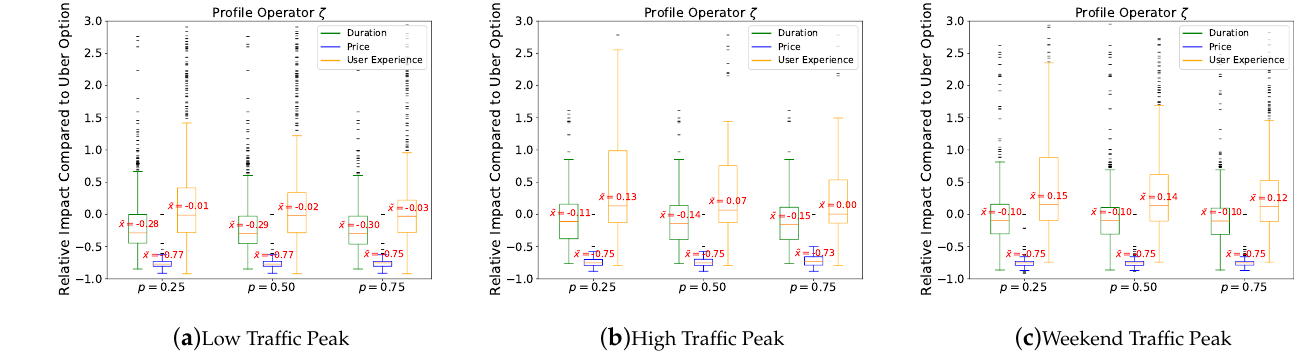
Figure 10. Relative impact of different users’ profiles in the route